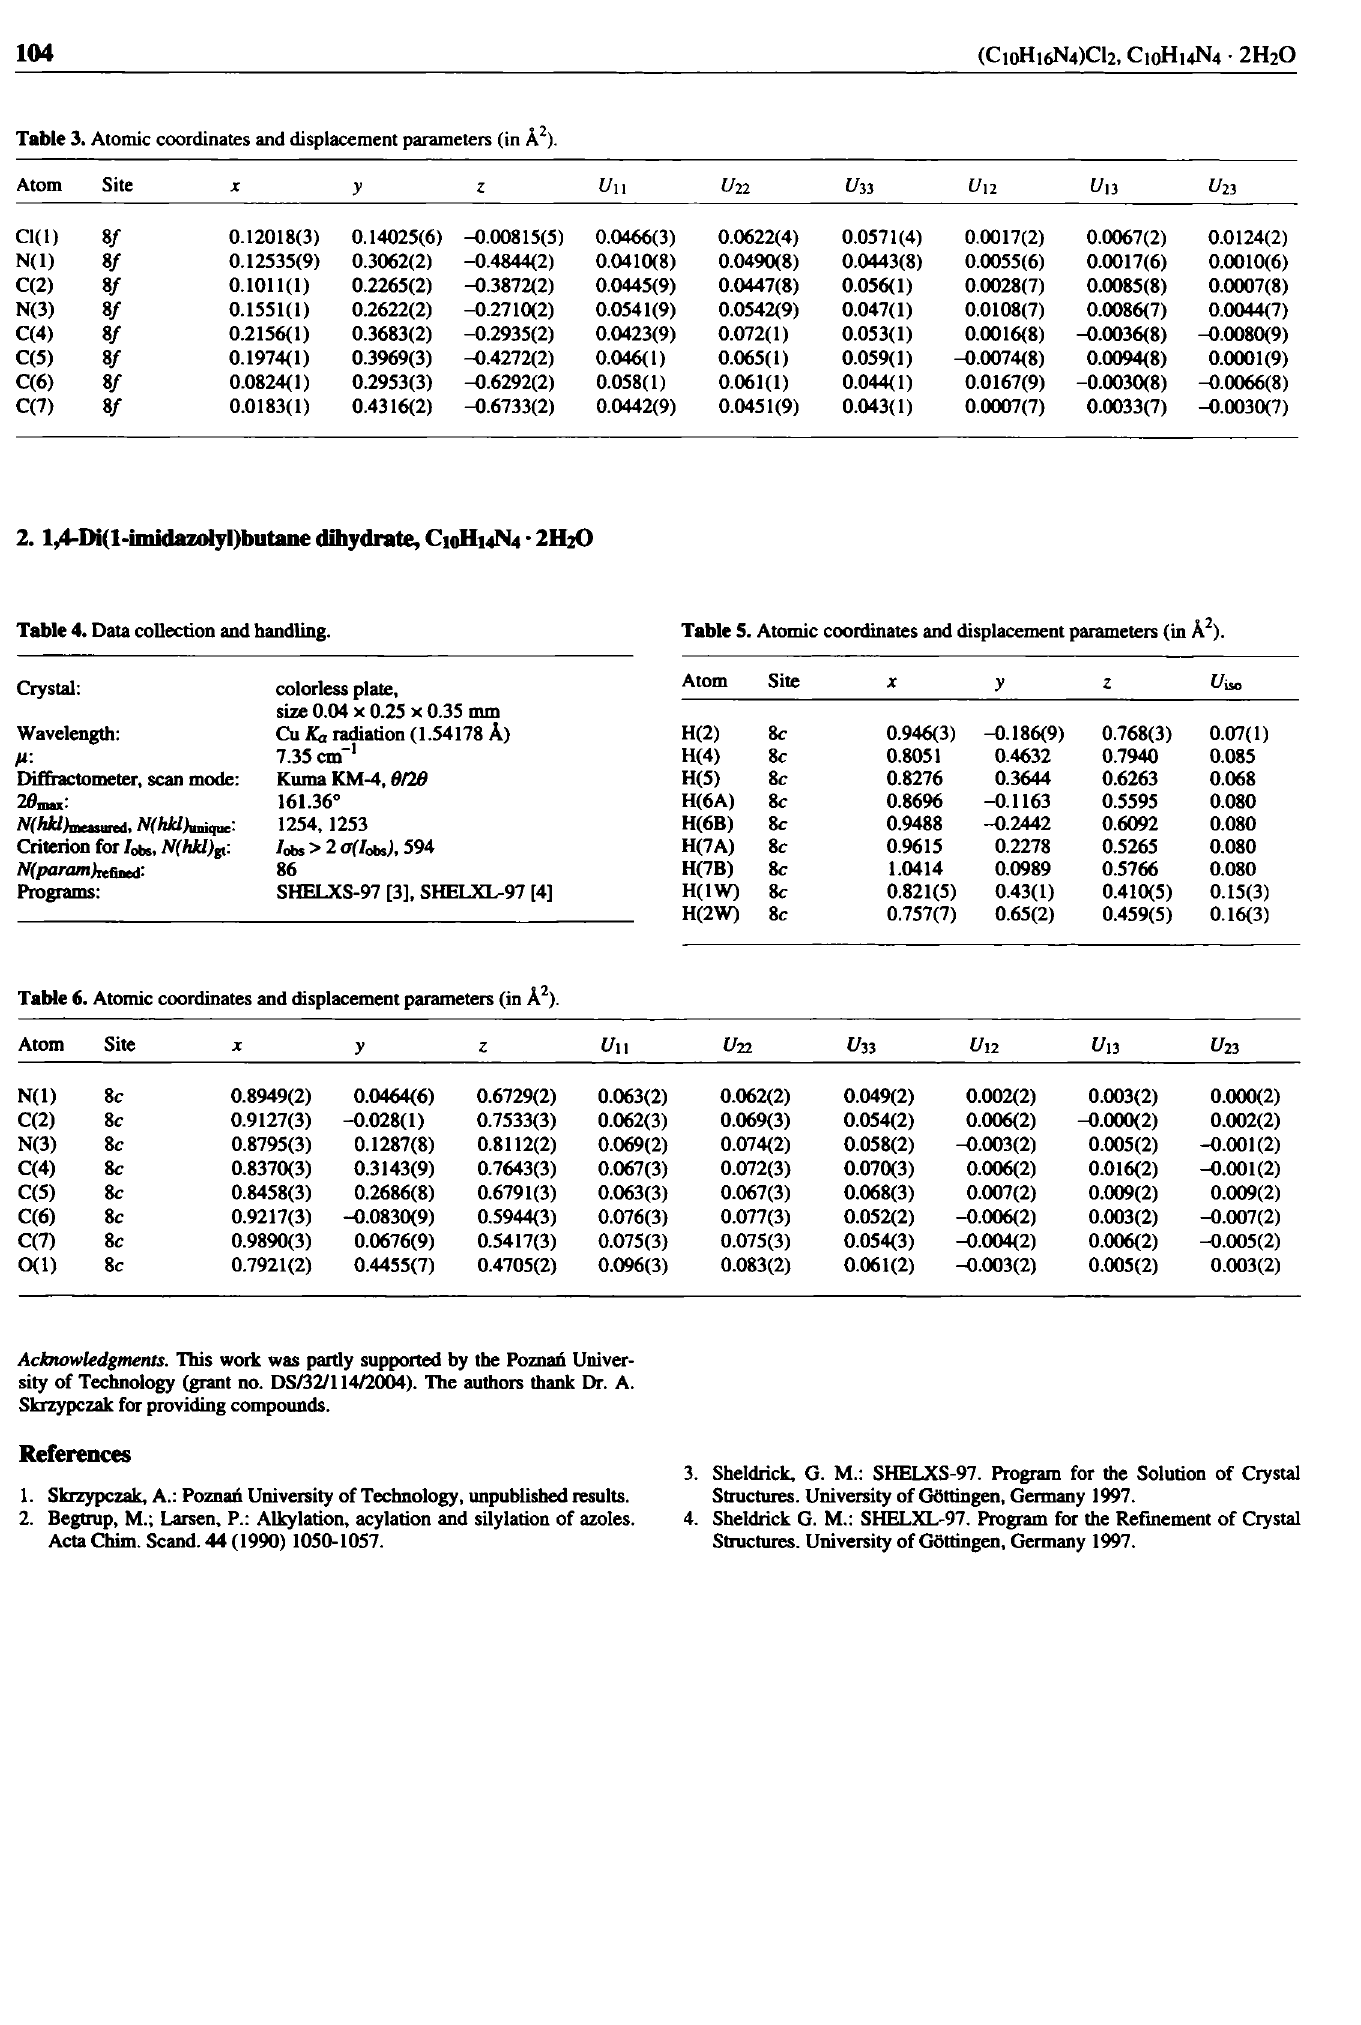
Table 3. Atomic coordinates and displacement parameters (in A 2 ).